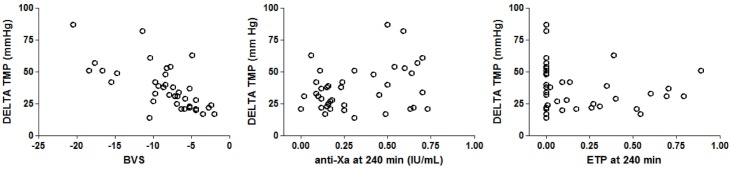
Delta transmembrane pressure (TMP) in relation to hemoconcentration (BVS), anti-Xa-activity and endogenous thrombin potential (ETP).Delta TMP is inversely correlated with hemoconcentration (p<0.0001, Spearman r = -0.68), no significant correlation between delta TMP and anti-Xa level or ETP at 240 min.